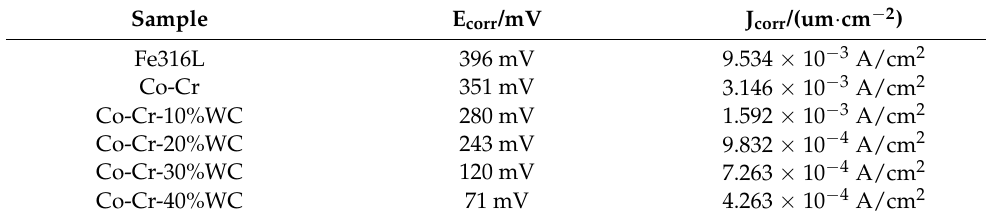
Figure 12. Potentiodynamic polarization curves of different cladding layers. Table 4. Corrosion current density comparison of different cladding layers.